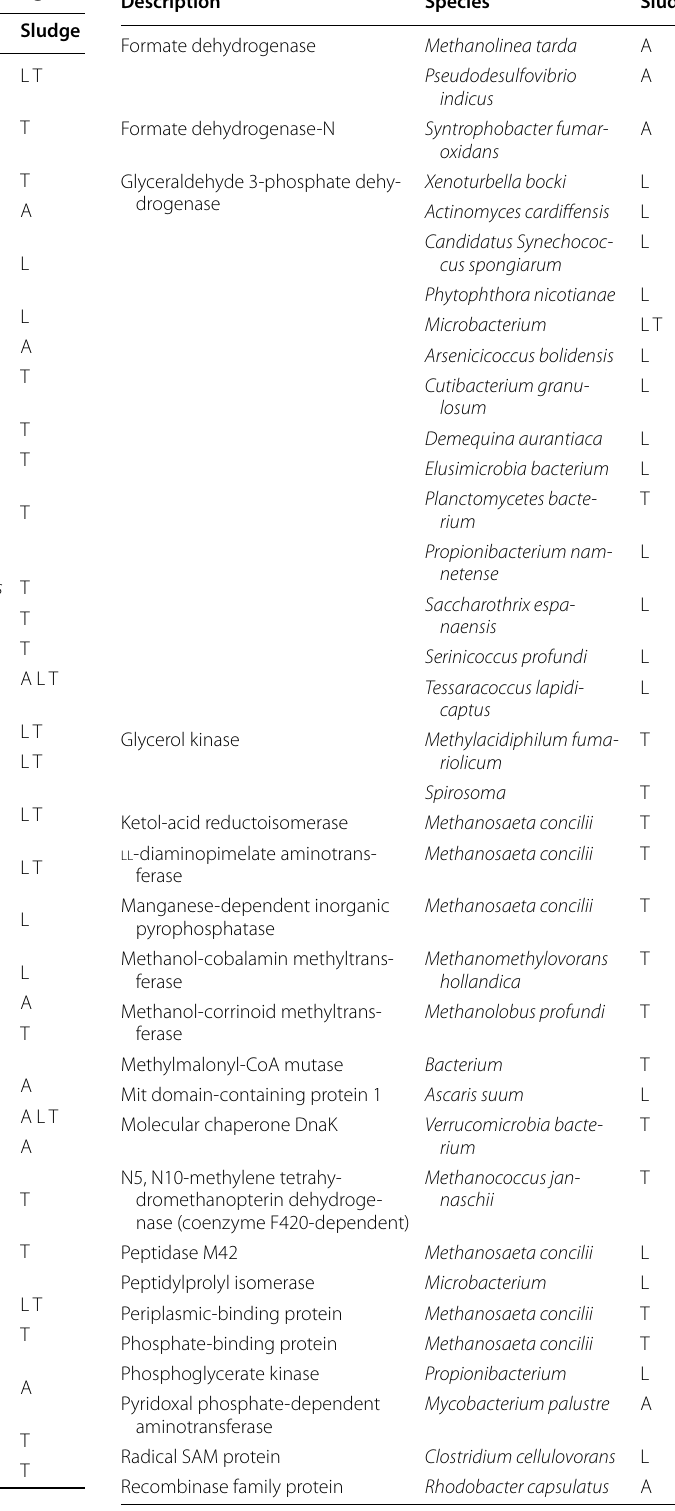
Table 5 Identified proteins and microbial species that produce them, in the EPS of the three tested